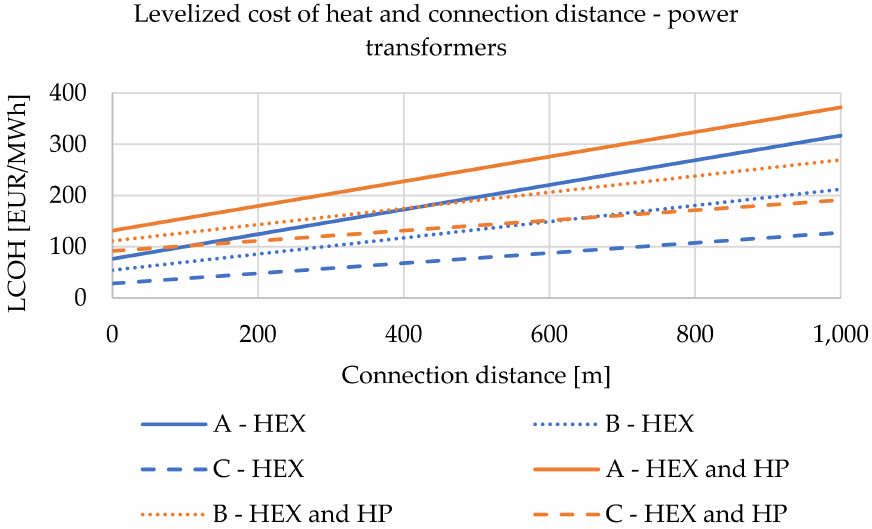
Figure 21. Levelized cost of heat and connection distance for power transformers waste heat and different utilization technologies—Scenario A: Heat exchanger and heat